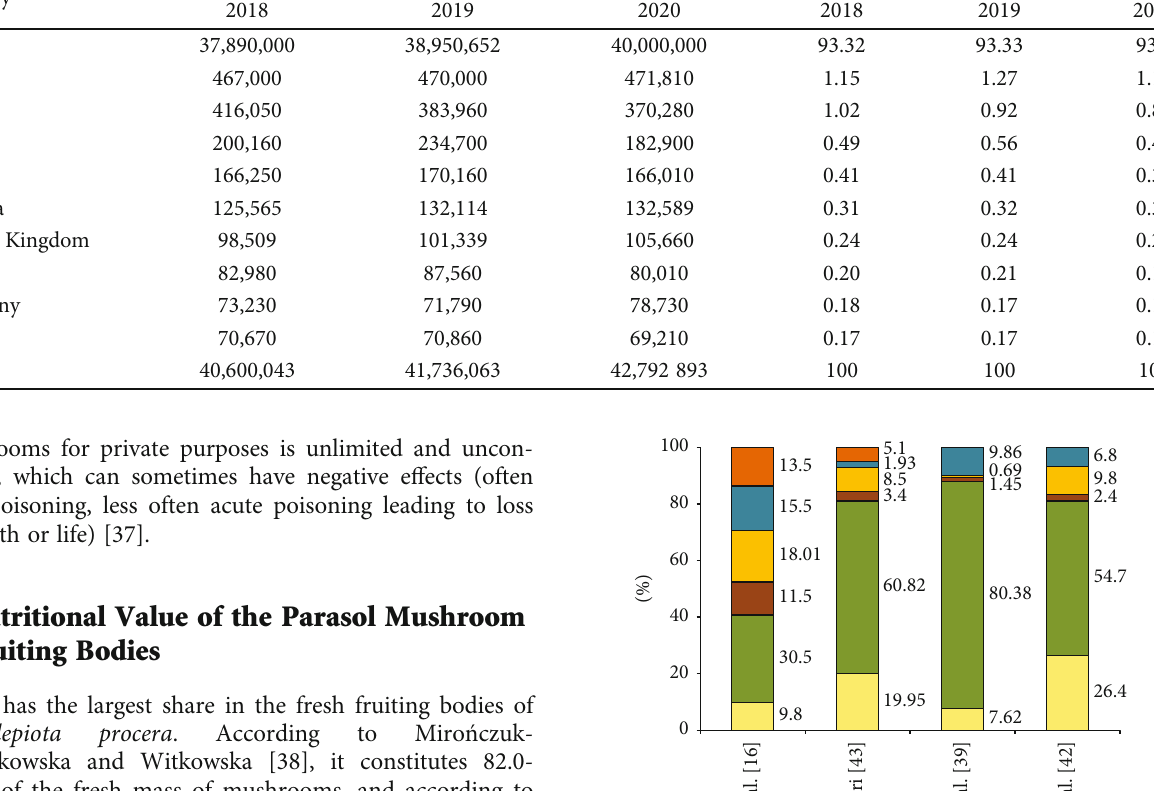
Table 1: Production of cultivated mushrooms in the world in 2018-2020 (data according to FAOSTAT [17]). Country